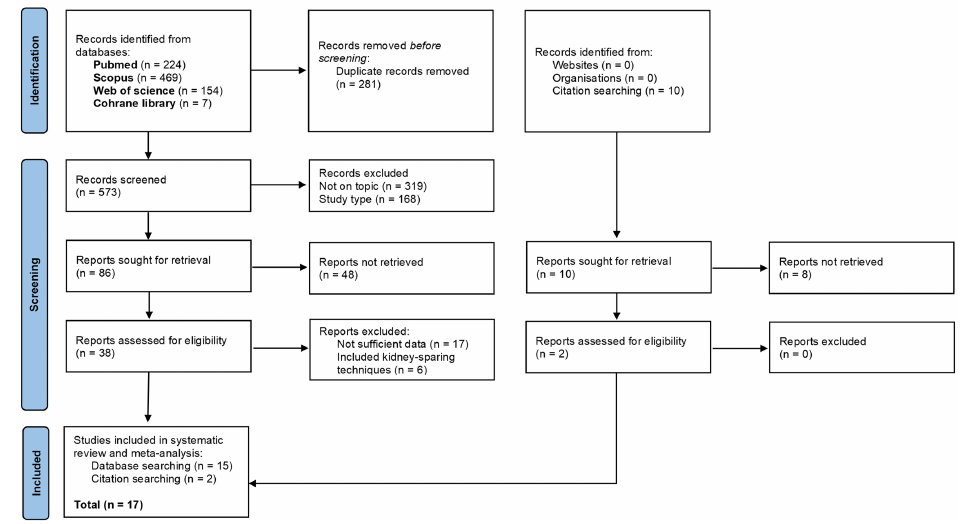
Figure 1. Preferred reporting items for systematic reviews and meta-analysis (PRISMA) flowchart.